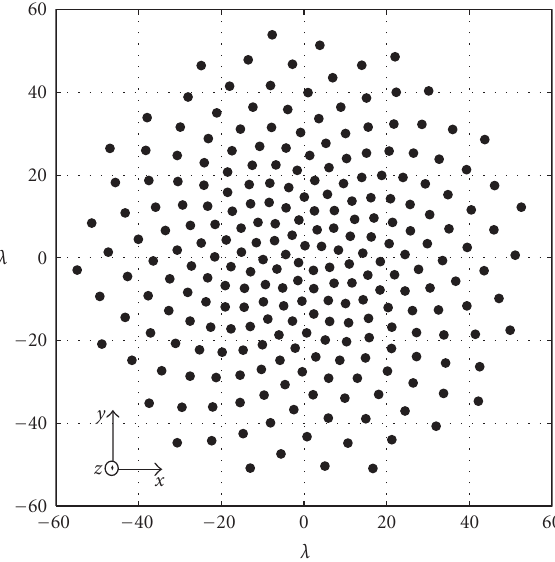
Figure 2: Distribution of the 250 elements in the tapered sunflower array